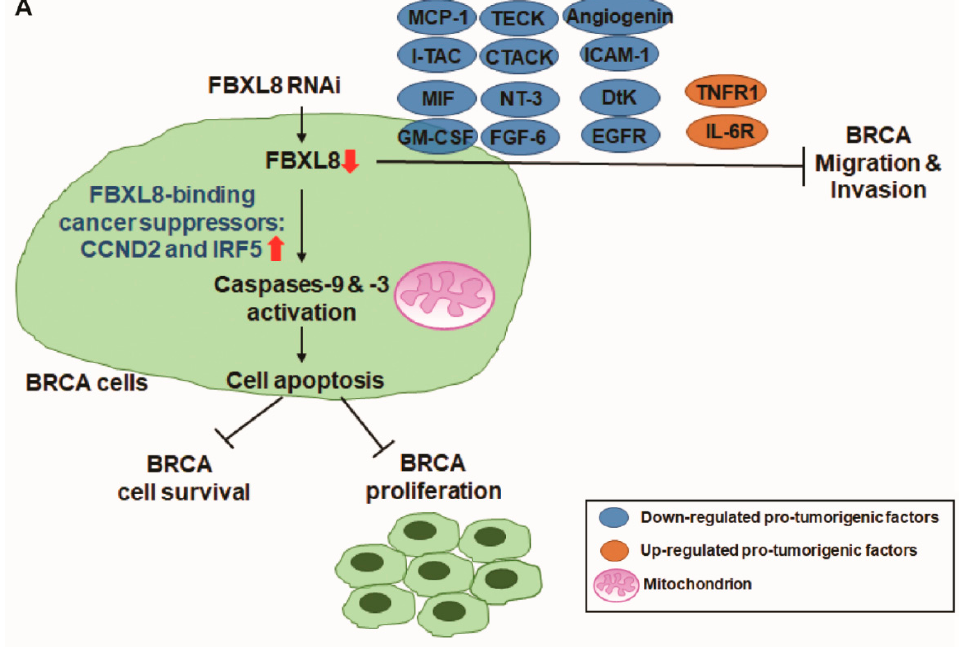
Figure 7. Cont Figure 7. Cont.